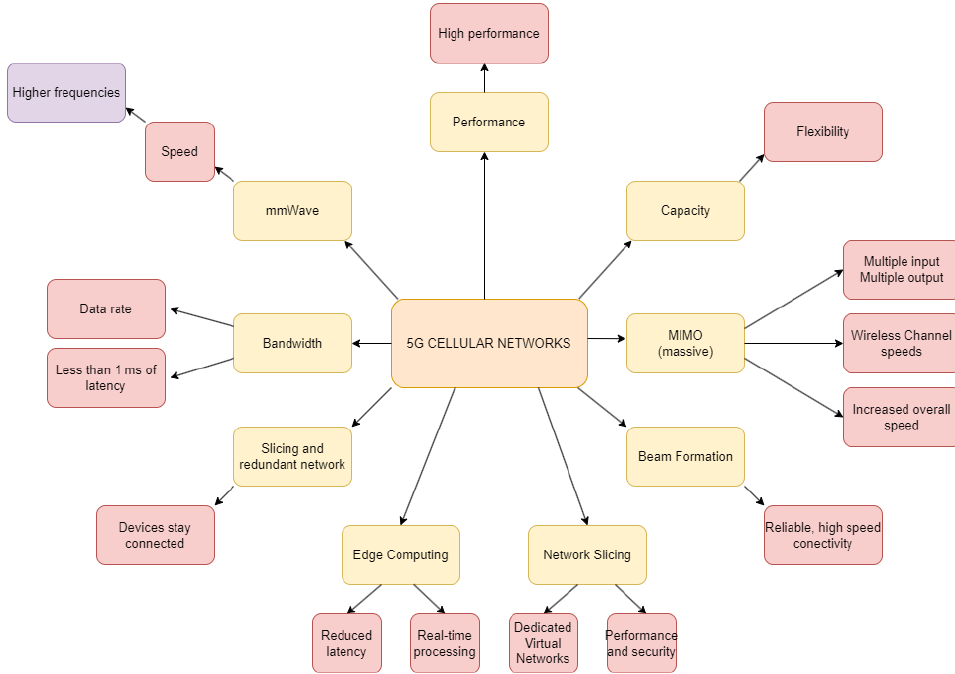
Figure 6. 5G implementation